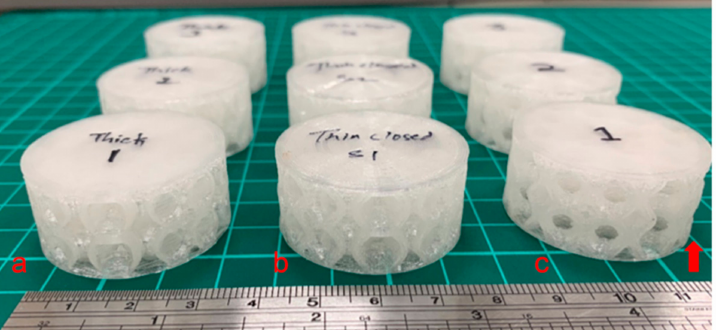
Figure 4. AM using MEX process: ( a ) thick-wall closed-cells; ( b ) thin-wall closed-cells; ( c ) open-cells. The arrow represents the build